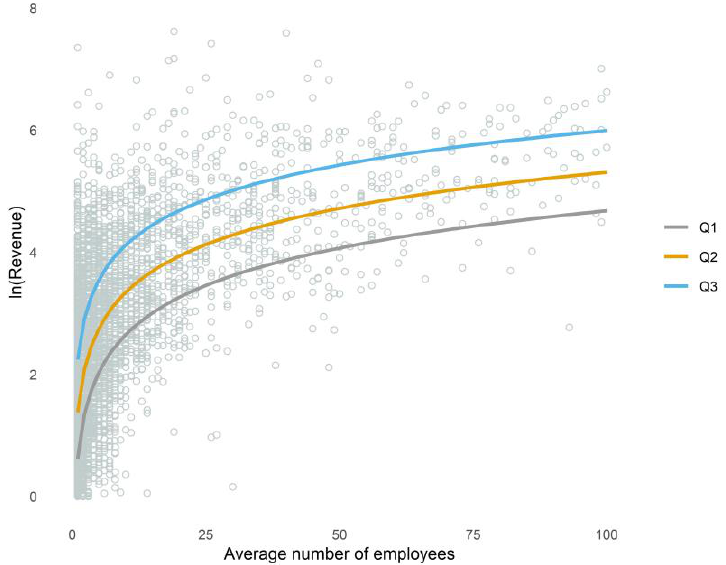
Figure 4. The scatterplot for the logarithm of revenue and the average number of employees in Asian Russian forest companies. Table 5. OLS and quantile regression results for Asian Russian companies by activity